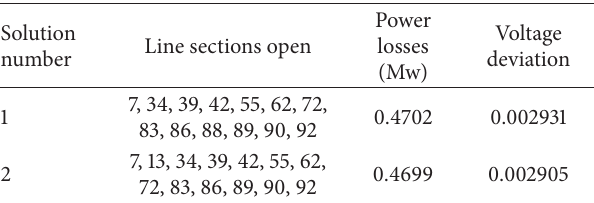
Figure 8: Approximate Pareto-optimal solutions to the problem of optimizing power losses 𝑓 1 and voltage deviations 𝑓 2 .